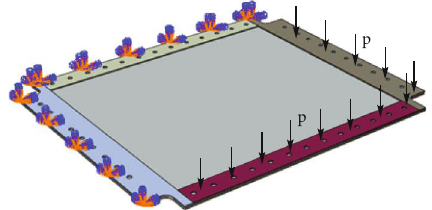
Table 6: Composite layup